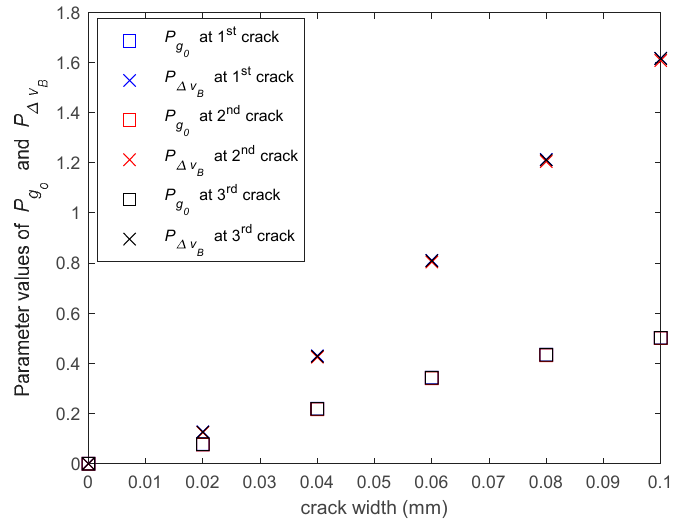
ff erent crack locations with di ff erent crack and 𝑃 at different crack locations with different crack widths. Figure 14. Values of P g 0 and P ∆ v B at di (cid:3034) (cid:3116) (cid:2940)(cid:3049) (cid:3251)